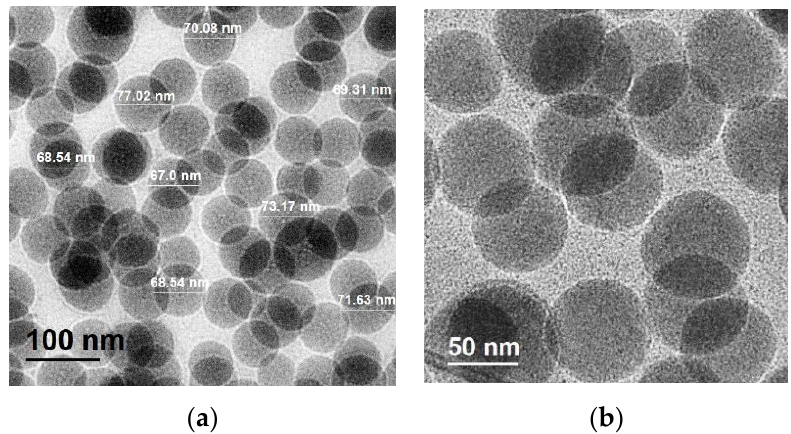
Table 4. Elemental analysis of SiO 2 NPs.